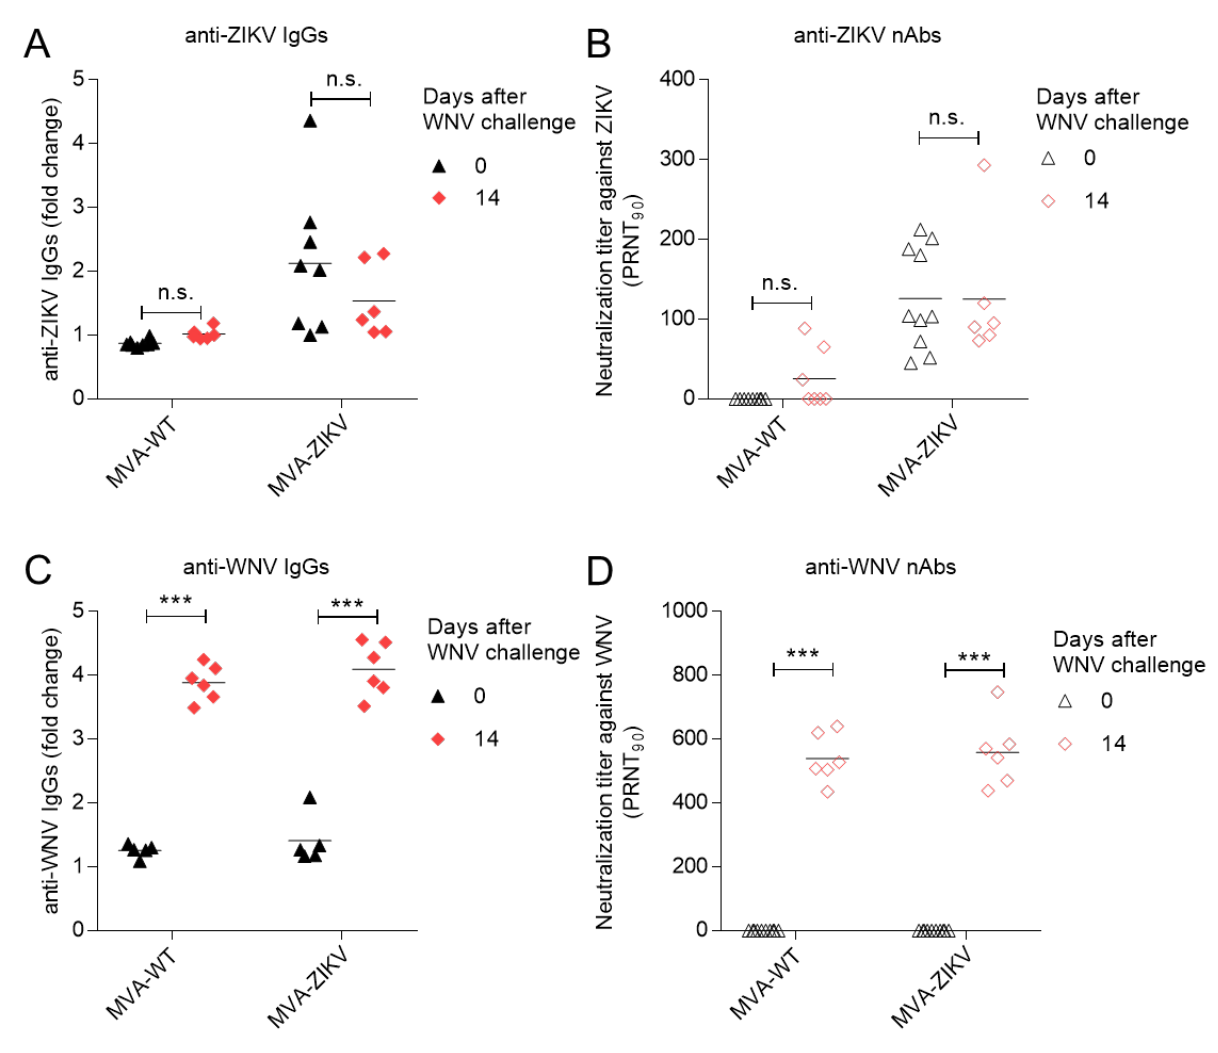
Figure 2. Analysis of antigen-specific humoral responses elicited in CD1 mice vaccinated with MVA-WT or MVA-ZIKV and challenged with WNV. ( A ) Induction of anti-ZIKV IgG antibodies in mice immunized with MVA-ZIKV or MVA-WT and analyzed by ELISA. Values correspond to the fold change over negative serum samples obtained before immunization. ( B ) Induction of anti-ZIKV neutralizing antibodies (nAbs). Data are expressed as the reciprocal serum dilution that neutralized 90% of ZIKV (PRNT 90 ). ( C ) Induction of anti-WNV IgG antibodies analyzed by ELISA. ( D ) Induction of anti-WNV nAbs. Each symbol in the graphs denotes a single animal. Three asterisks (***) denote statistically significant differences ( p < 0.0001) and n.s. indicates not statistically significant differences. Two-way ANOVA Tukey’s multiple comparison was performed with Graphpad Prism 7.0. For experimental design, see panel (A) in Figure 1. At 14 days post-WNV challenge, levels of total ZIKV-E-specific binding IgG